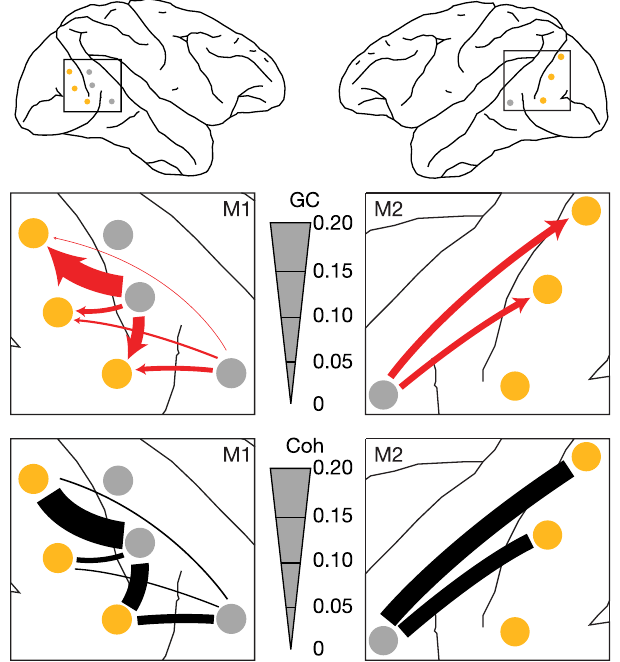
Figure 4. Prestimulus Beta-Frequency Coherence and Top-down sGC Maps. Top: Maps of the recording sites for M1 and M2. V1/V2 electrode locations are marked by yellow circles, and extrastriate (V4 and TEO) locations by gray circles. Middle: enlarged maps of visual cortex showing top-down sGC at 16 Hz as arrows for V1/V2-extrastriate pairs having their mean peak frequency inside the 95% confidence interval of Fig. 3. Bottom: corresponding maps of coherence for the same site pairs. Thickness of the top-down sGC arrows and coherence bars is proportional to the magnitude of sGC or coherence at 16 Hz. Surgical brain maps were provided by Richard